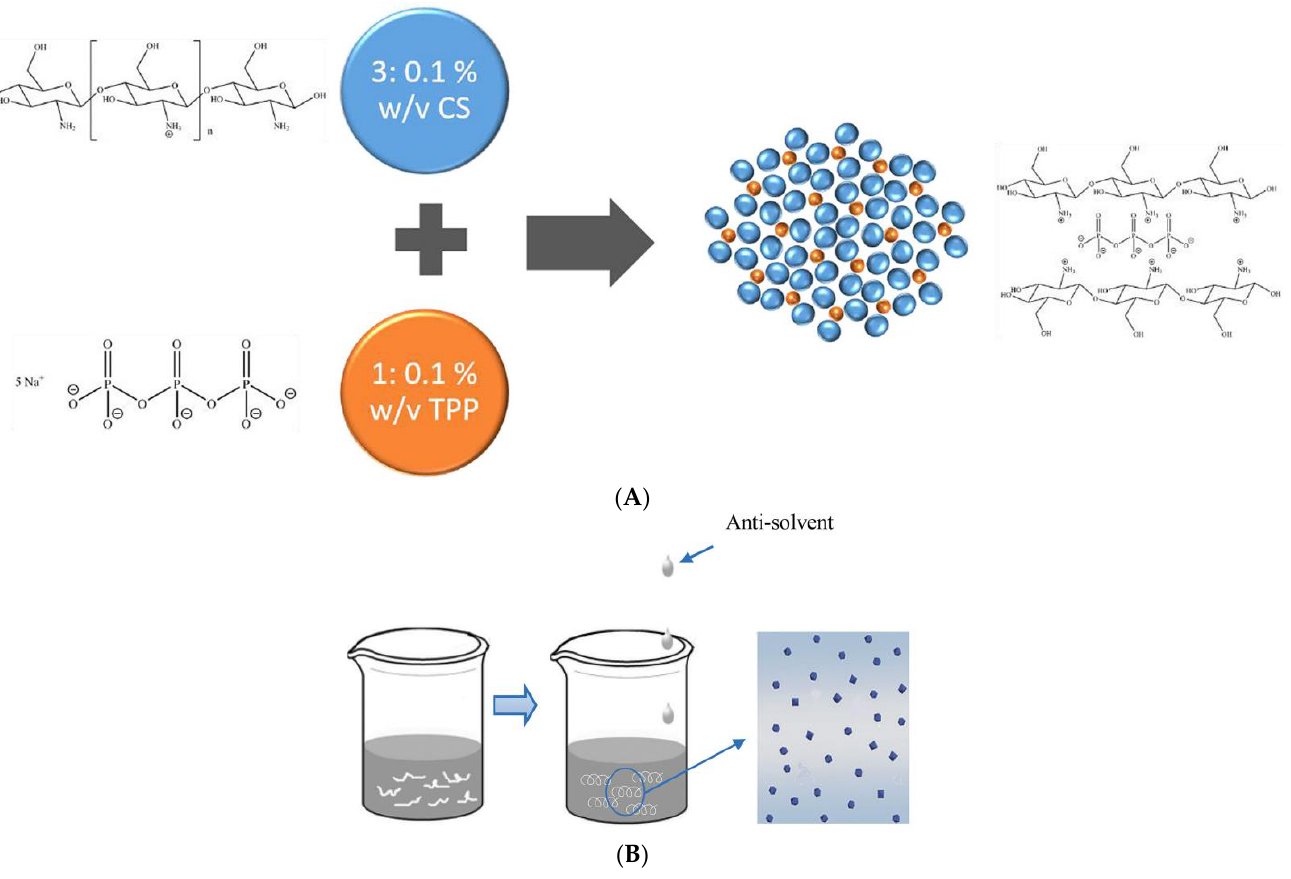
Figure 1. ( A ) Crosslinking of charged chitosan with sodium tripolyphosphate, reprinted with permission from [38], 2018, Elsevier. ( B ) Schematic illustration of the nanoprecipitation method, reprinted with permission from [44], 2019,